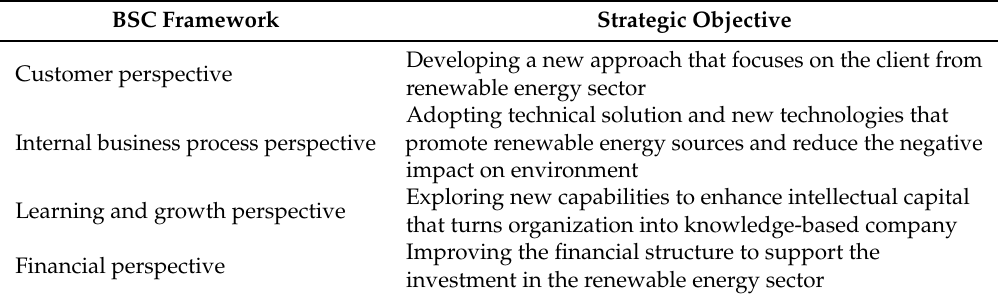
Table 4. Strategic objectives in the renewable energy sector (adapted from